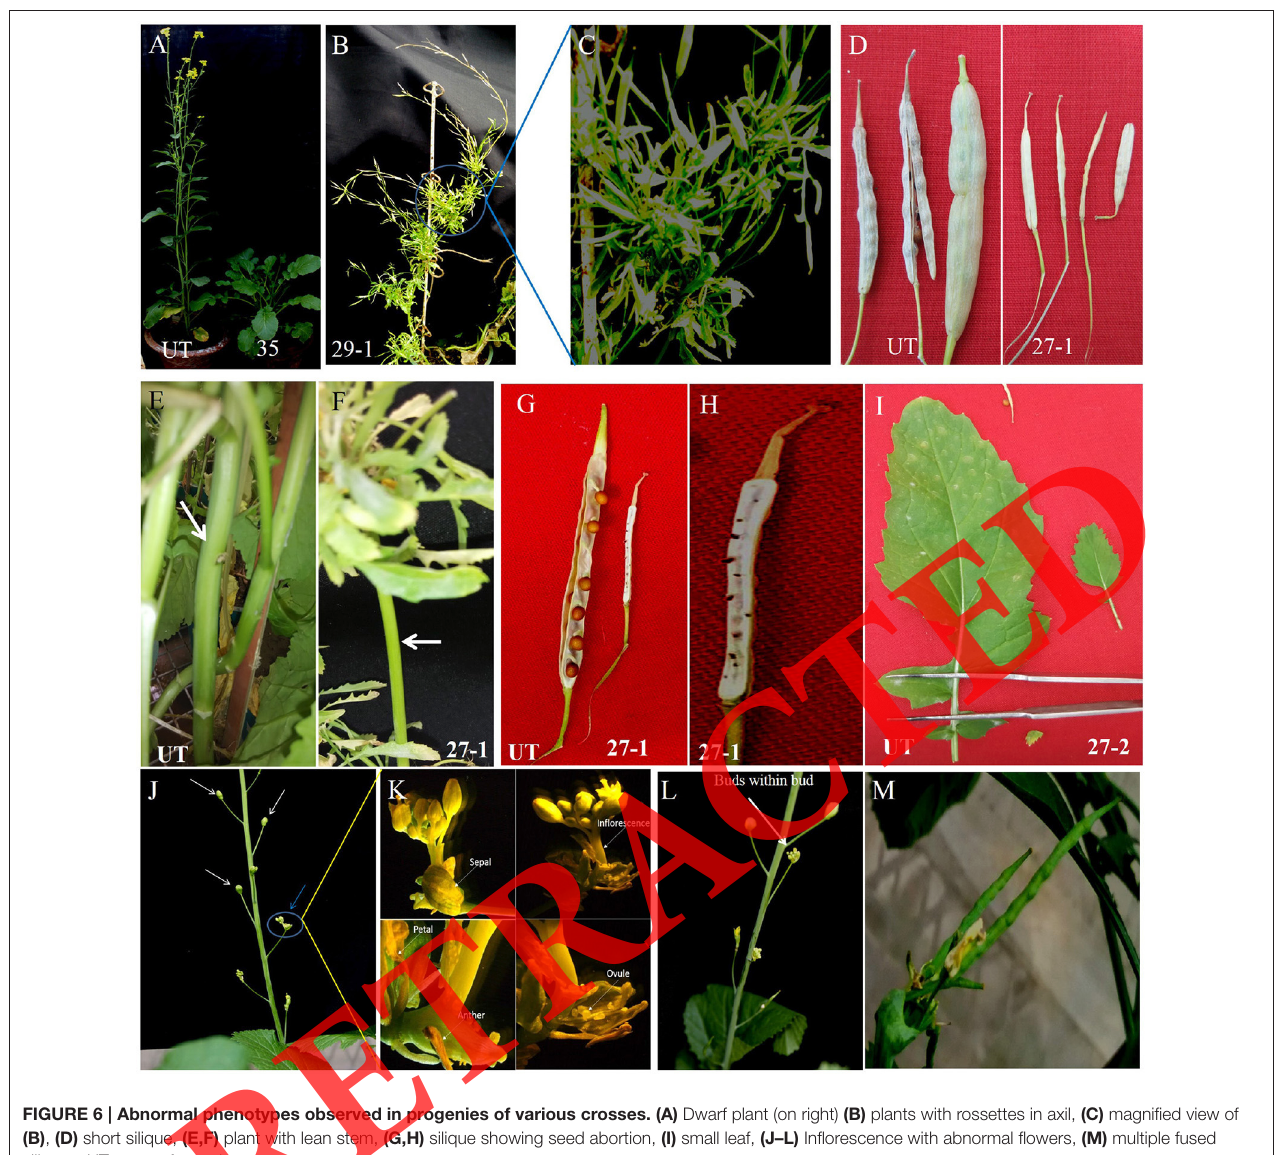
FIGURE 6 | Abnormal phenotypes observed in progenies of various crosses. (A) Dwarf plant (on right) (B) plants with rossettes in axil, (C) magnified view of (B) , (D) short silique, (E,F) plant with lean stem, (G,H) silique showing seed abortion, (I) small leaf, (J–L) Inflorescence with abnormal flowers, (M) multiple fused siliques.